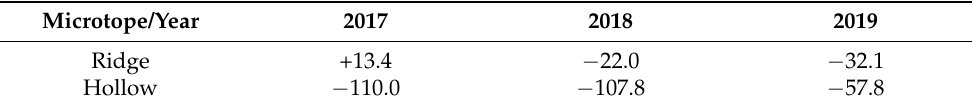
Table 2. Annual net ecosystem exchange (gC m − 2 ) values for the ridge and hollow.